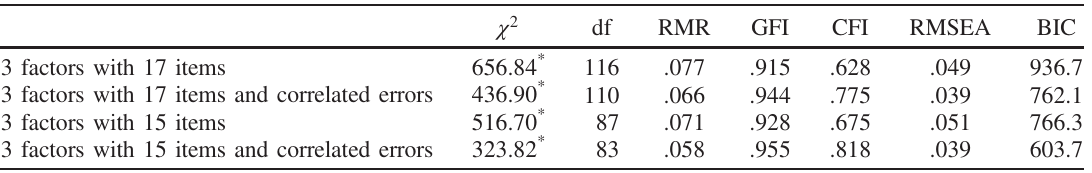
TABLE III. Confirmatory factor model and fit